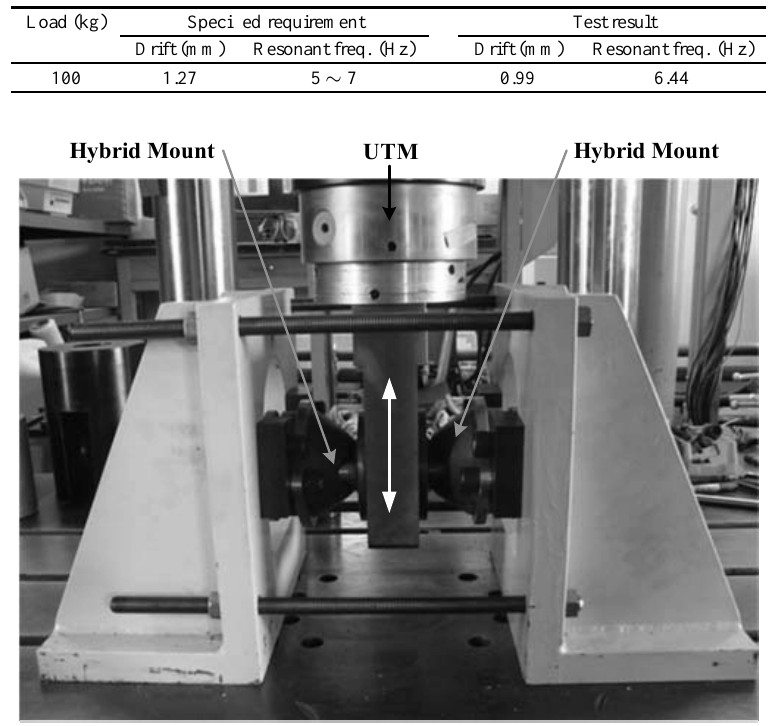
Fig. 13. Photograph of strength test in the radial direction.